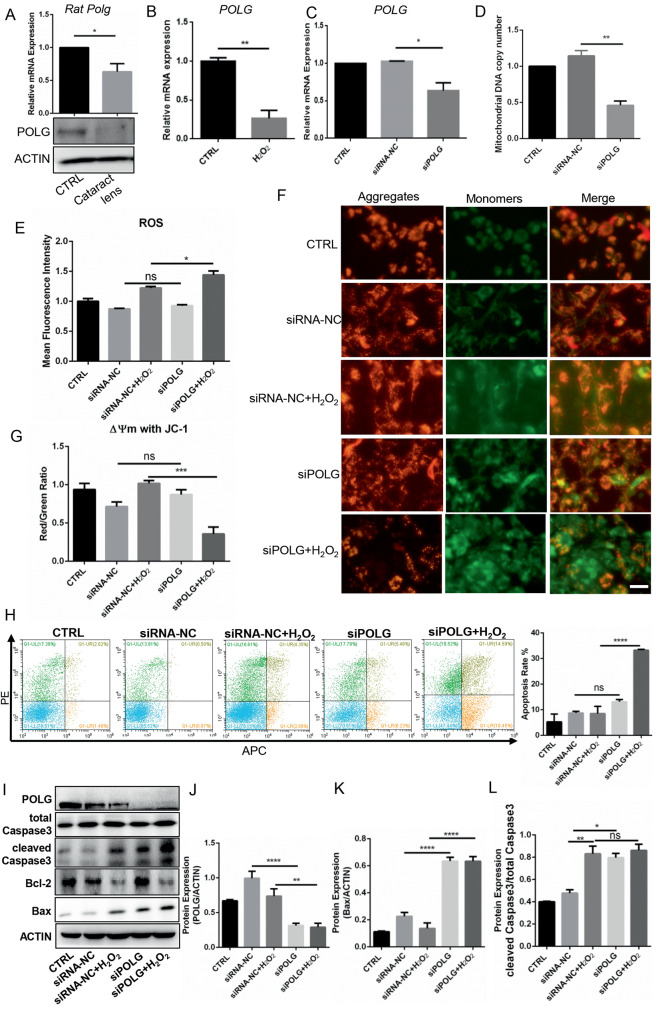

POLG knockdown increased the sensitivity of B3 cells to ROS. (A) Detection of Polg mRNA expression in the lenses of rats with cataracts by RT-qPCR. (B) POLG mRNA expression in the oxidative stress cell model shown by RT-qPCR. (C) Efficacy of POLG siRNA knockdown shown by RT-qPCR. (D) MtDNA copy number after POLG silencing shown by RT-qPCR. (E) Flow cytometric detection of the mean fluorescence intensity of ROS. (F–G) Microplate spectrophotometer analysis of MMP by JC-1 staining. The JC-1 monomer was green, representing a low MMP, and JC aggregates were red, representing a high MMP. (H) Flow cytometry was used to test apoptosis of the POLG-silenced cells with or without H2O2 loading and apoptotic cell rate quantification. (I) Western blot characterization of apoptosis-associated protein and POLG expression. (J–L) Quantification of the Western blot results. Scale bar: 100 µm. *P < 0.05, **P < 0.01, ***P < 0.0001, ****P < 0.00001, ns: P > 0.05.